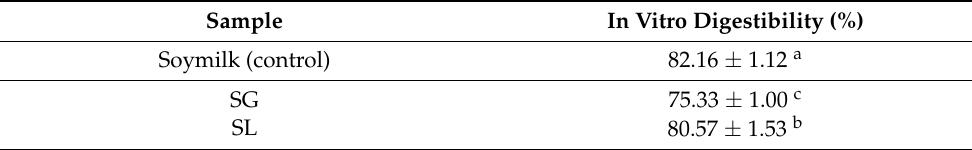
Table 1. In vitro digestibility of soymilk and both soymilk gels 1,2 .